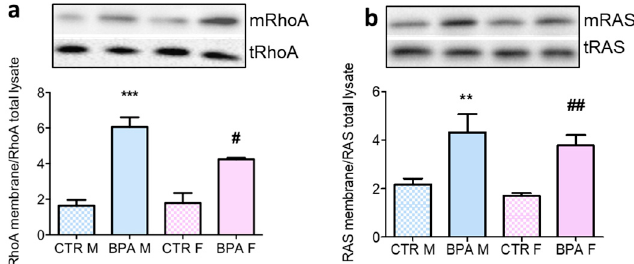
Figure 6. RhoA and Ras activation in the brain of rat fetuses in utero exposed to 2.5 µg/kg/day of BPA. Representative Western blots of membrane-bound RhoA ( a ) and Ras ( b ) and their content in total lysate of fetuses brain from prenatally BPA exposed and CTR animals. The graphs represent the ratio of membrane-bound and total levels of the proteins in brain lysates. n = 6 for each experimental group. Statistical analysis was carried out by using two-way ANOVA followed by Bonferroni post-hoc test. ** = p < 0.01 vs. CTR M; *** = p < 0.001 vs. CTR M; # = p < 0.05 vs. CTR F; ## = p < 0.01 vs. CTR F.